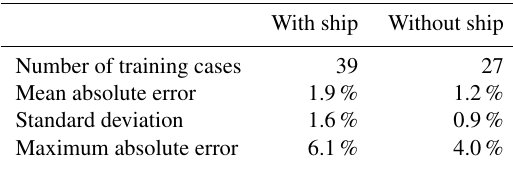
Table 3. Results of the bootstrapping procedure for cases with and without considering the ship-induced obstacle